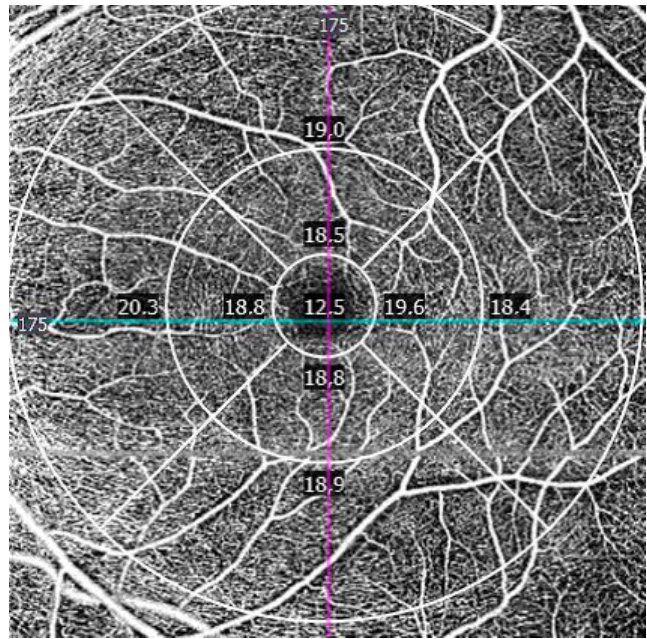
Figure 3. Vessel density map at the macula. Units are indicated in mm / mm 2 .